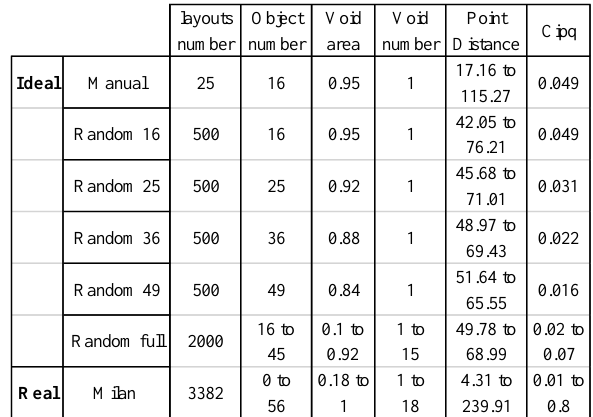
Table 1 . Size of the different sets with the range of values for the V0 statistics of all the parameters. H-index is not considered as V0 is not applicable as always equal to 1